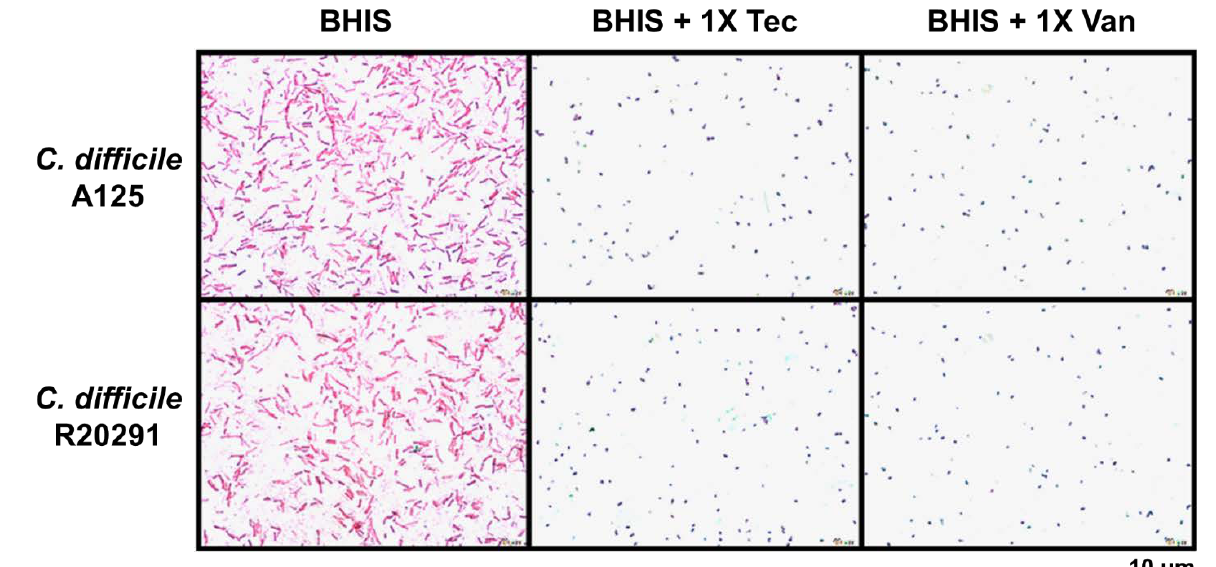
Figure 5. Antibiotic treatments limit the outgrowth of germinated C. difficile spores and prevent outgrowth to vegetative cells. C. difficile spores were incubated with BHIS medium supplemented with either 1× MIC of teicoplanin or vancomycin for 24 h. Germination inhibition and outgrowth were marked by Wirtz–Conklin staining. Vegetative cells were long filamentous and stained pink/purple, germinated cells were pink/purple spheres, outgrowths were pink/purple/faintly stained, blunted ends or extrusion from germinated cell. All the micrographs were taken at a magnification of 1000×, 5 fields counted, and repeated in triplicates to ensure the reproducibility of the results. Abbreviations: Tec = teicoplanin, Van = vancomycin, BHIS = Brain heart infusion broth supplemented with 0.1% sodium taurocholate (as negative control).